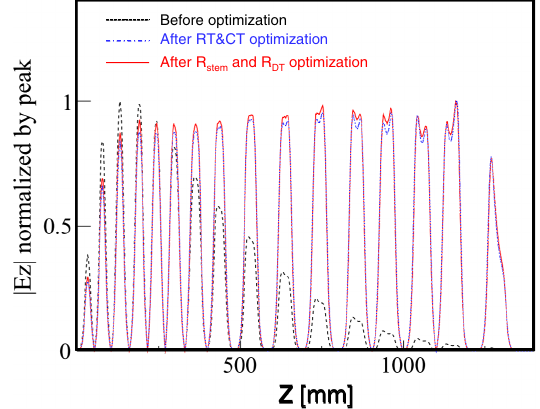
FIG. 5. Effects of ridge tuner (RT), cavity taper (CT), stem radius ( R ), and drift tube radius ( R ) adjustment. Horizontal stem DT axis is the distance from the cavity start on the beam axis, and vertical axis is the E normalized at the peak value. Black: z longitudinal electric field along z before optimizations, blue: field after optimizations with RT and CT, red: field after optimizations with R and R stem DT